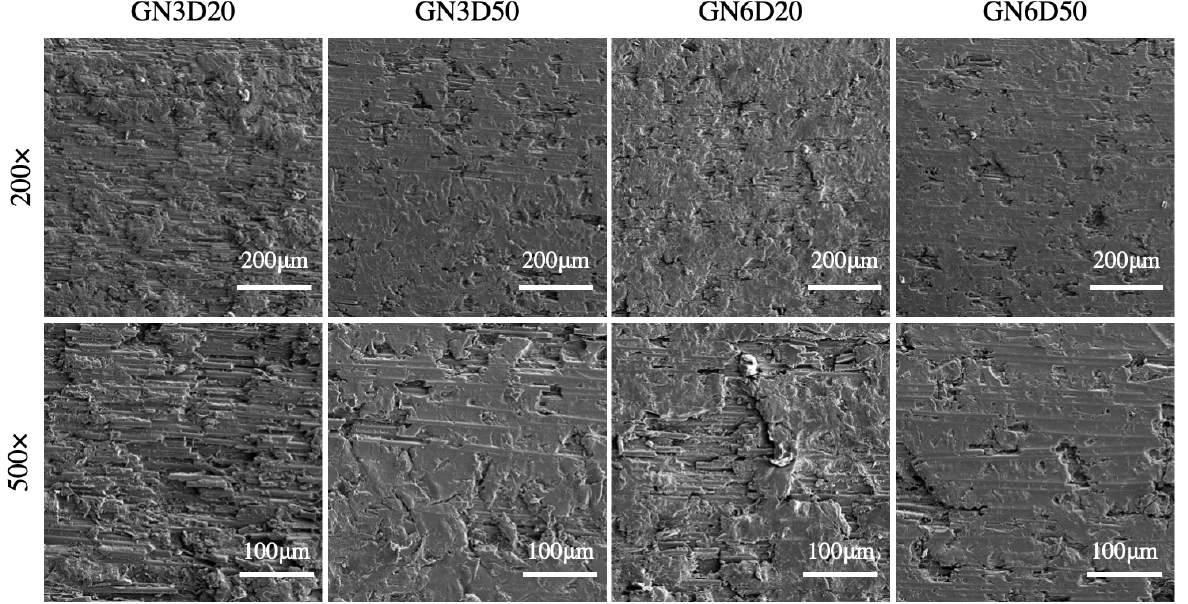
Figure 4. Scanning electron microscopy (SEM) images of CFRP surfaces grit-blasted using glass